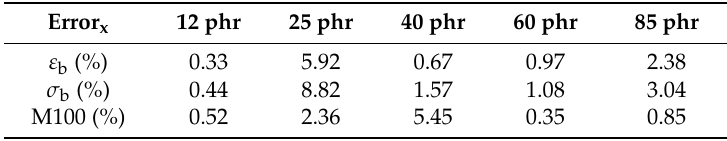
Table 1. Error estimation of mechanical characteristics X for modeled input model data. Error